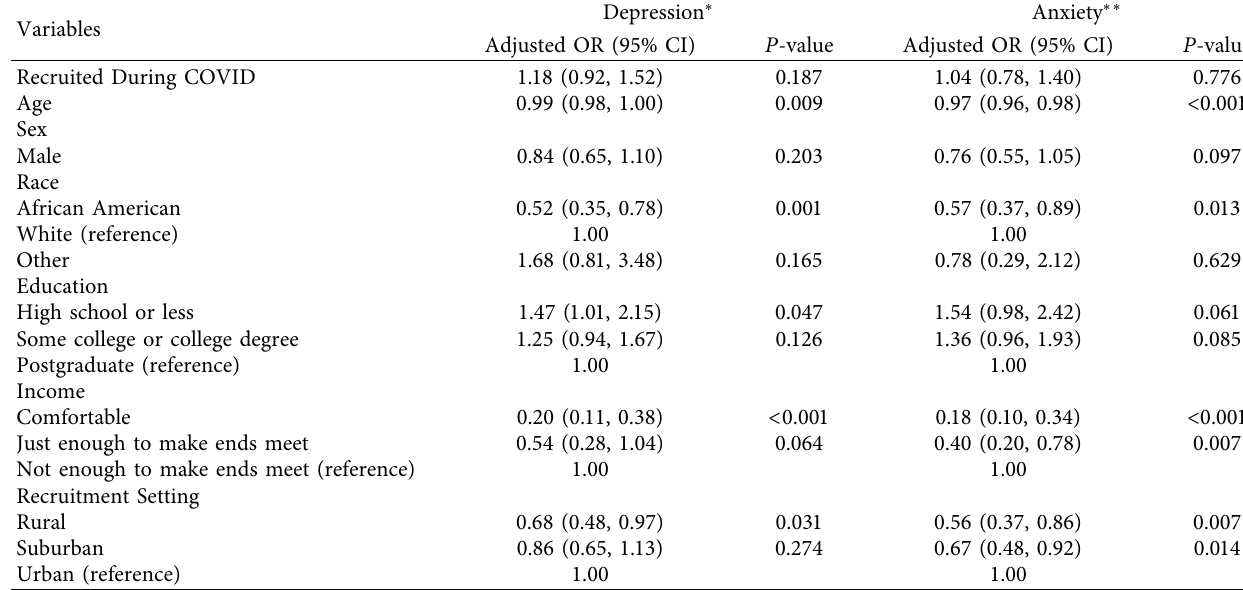
Table 3: Logistic regression results for family member depression and anxiety adjusting for family member characteristics.